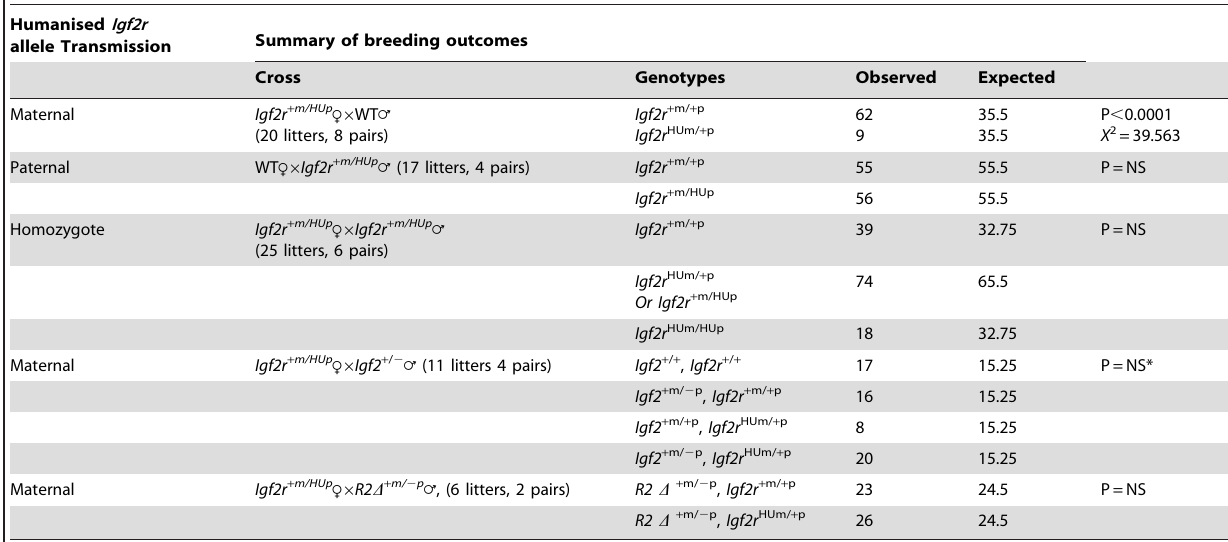
Table 1. Summary of breeding outcomes following humanised lgf2r allele transmission.